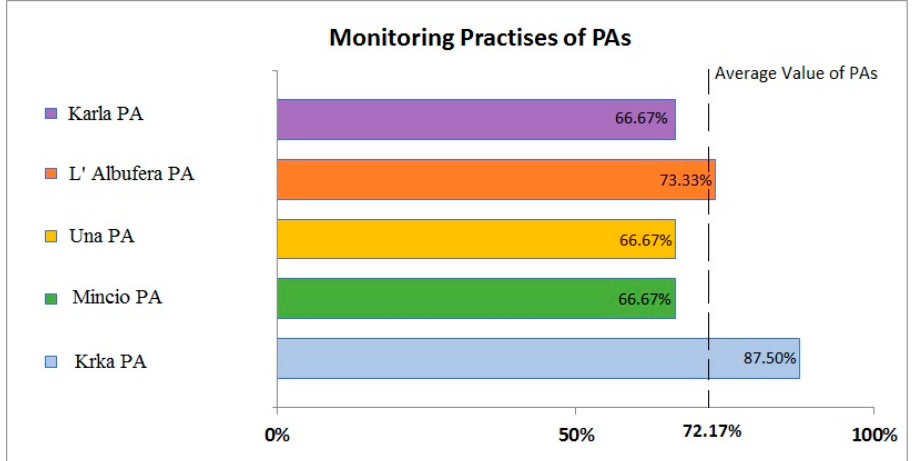
Figure 1. Gap rating on Monitoring Practices for each of the five